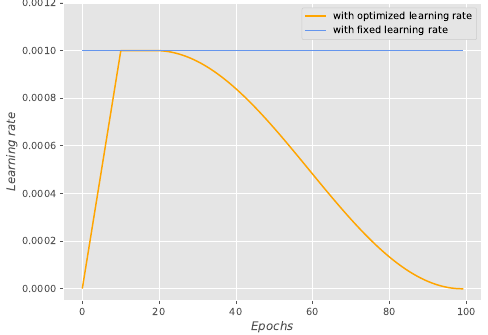
Figure 4. Changes of learning rate using optimization